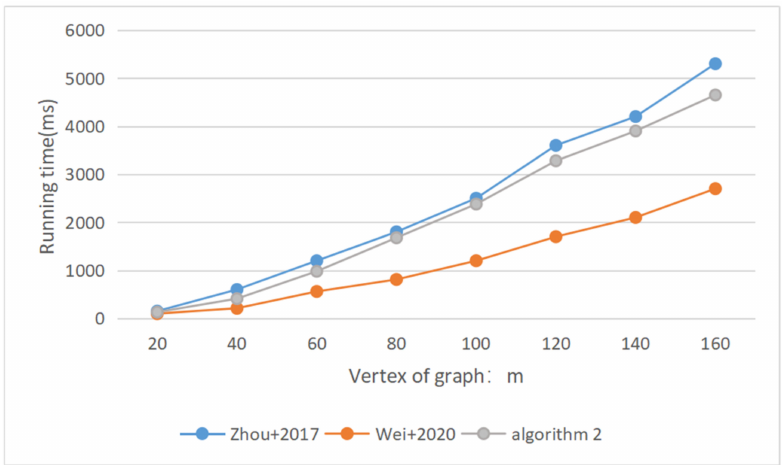
Figure 5. The running time of experimental